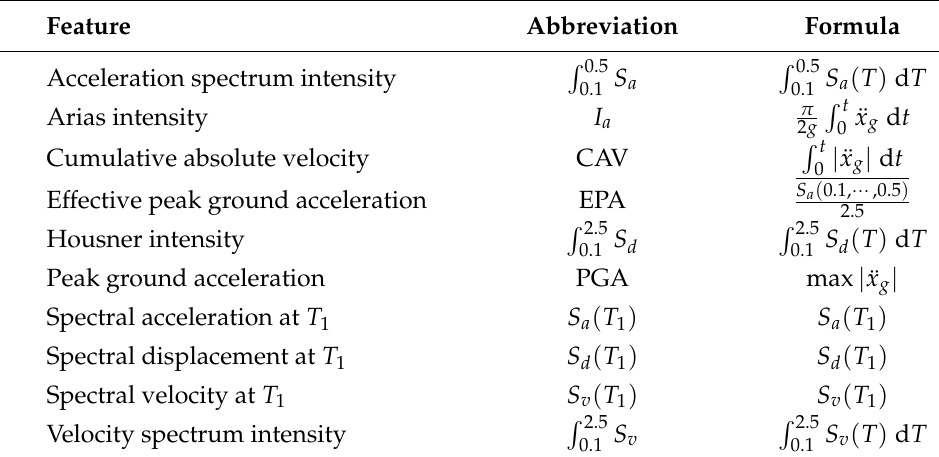
Table 1. Earthquake intensities used as neural network